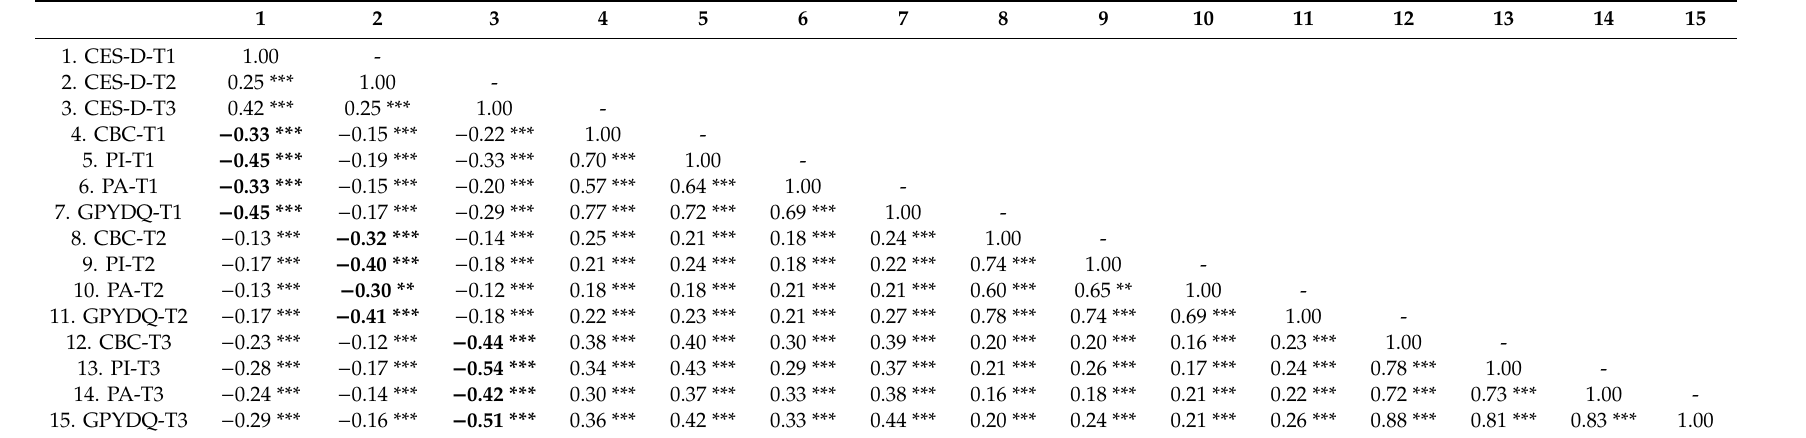
Table 4. Correlations of the four second-order PYD constructs with depressive